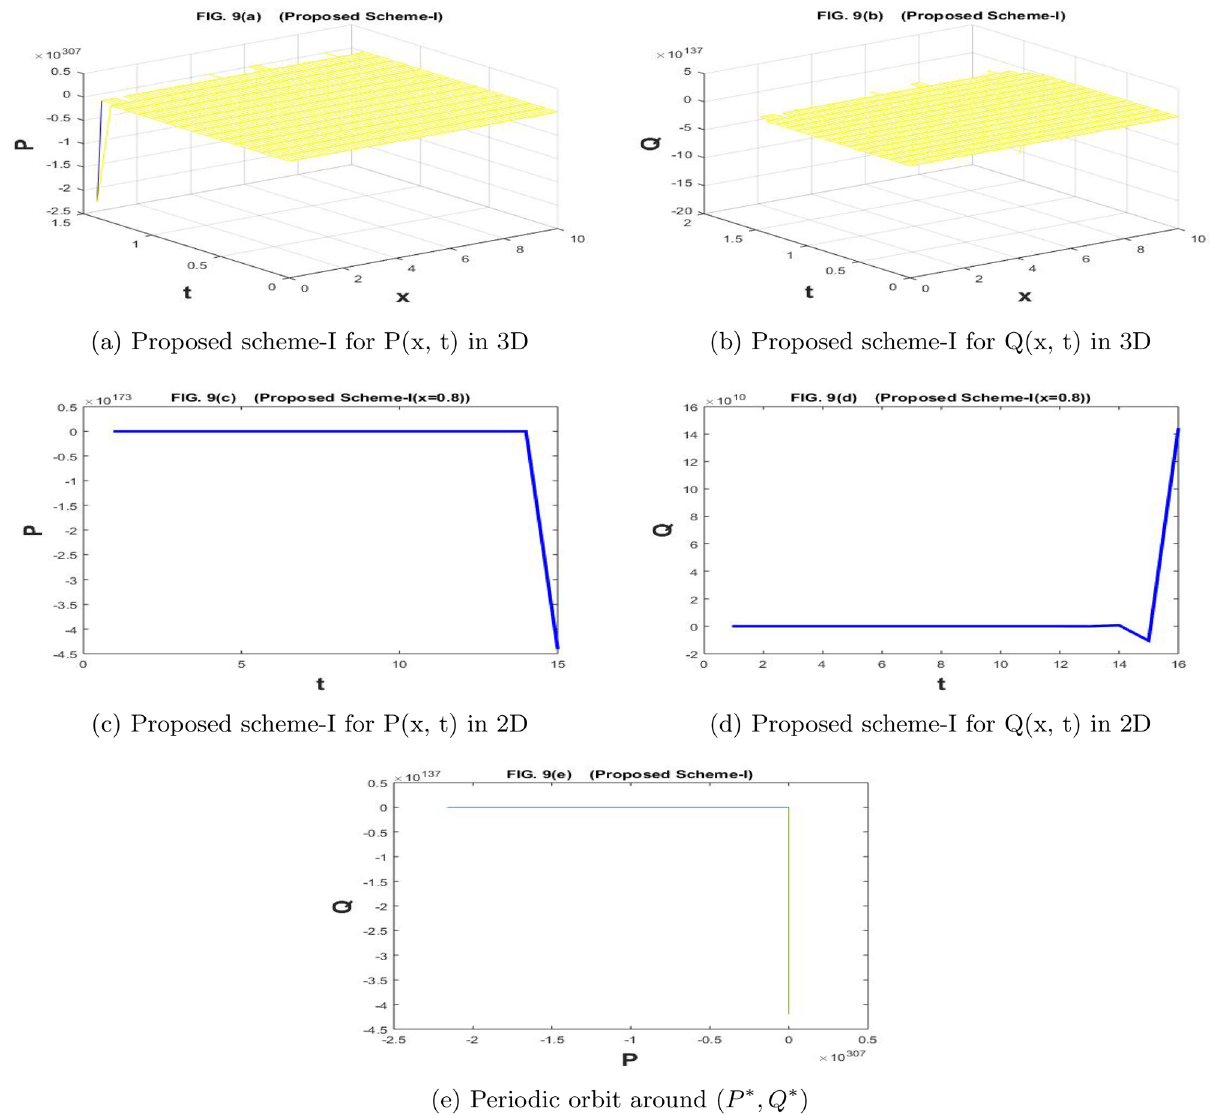
Figure 9. The subfig ( a and c ) and ( b and d ) represents the numerical approximation of P ( x , t ), and Q ( x , t ) respectively by proposed scheme-I. The subfig ( e ) represents the periodic orbit around ( P ∗ , Q ∗ )